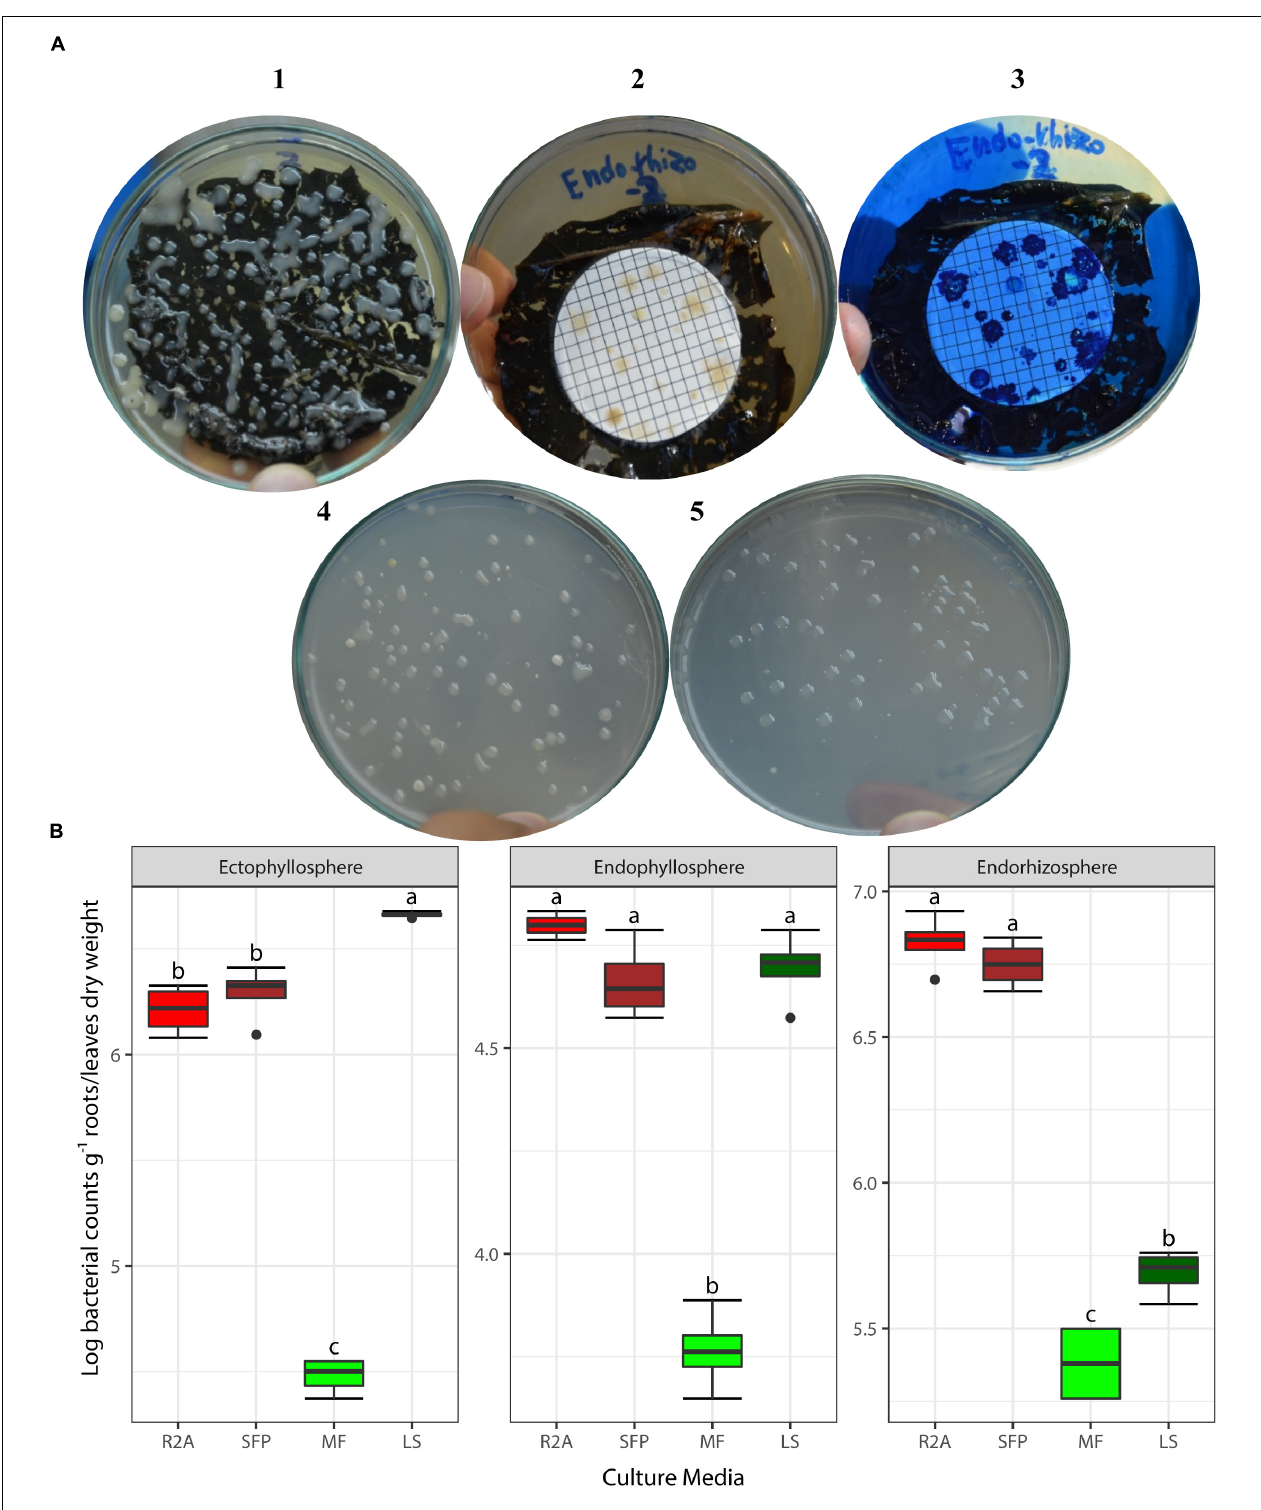
FIGURE 2 | (A) CFUs developed from culturing bacteria present in the endorhizosphere of sunflower plants. Colonies grown with both the leaf surface-inoculation (1) and leaf-membrane filter methods with and without staining (2, 3) compared to colonies developed on standard R2A medium (4) and plant-only-teabag culture media (5). (B) Two-way ANOVA, interaction of plant sphere and culture media: Log CFU counts recovered by the standard culture media (R2A medium and sunflower teabag, SFP) compared to the leaf-based culture media (MF, leaf-membrane filter; LS, leaf-surface-inoculated). Statistically significant differences (LSD) are indicated by different letters ( P value